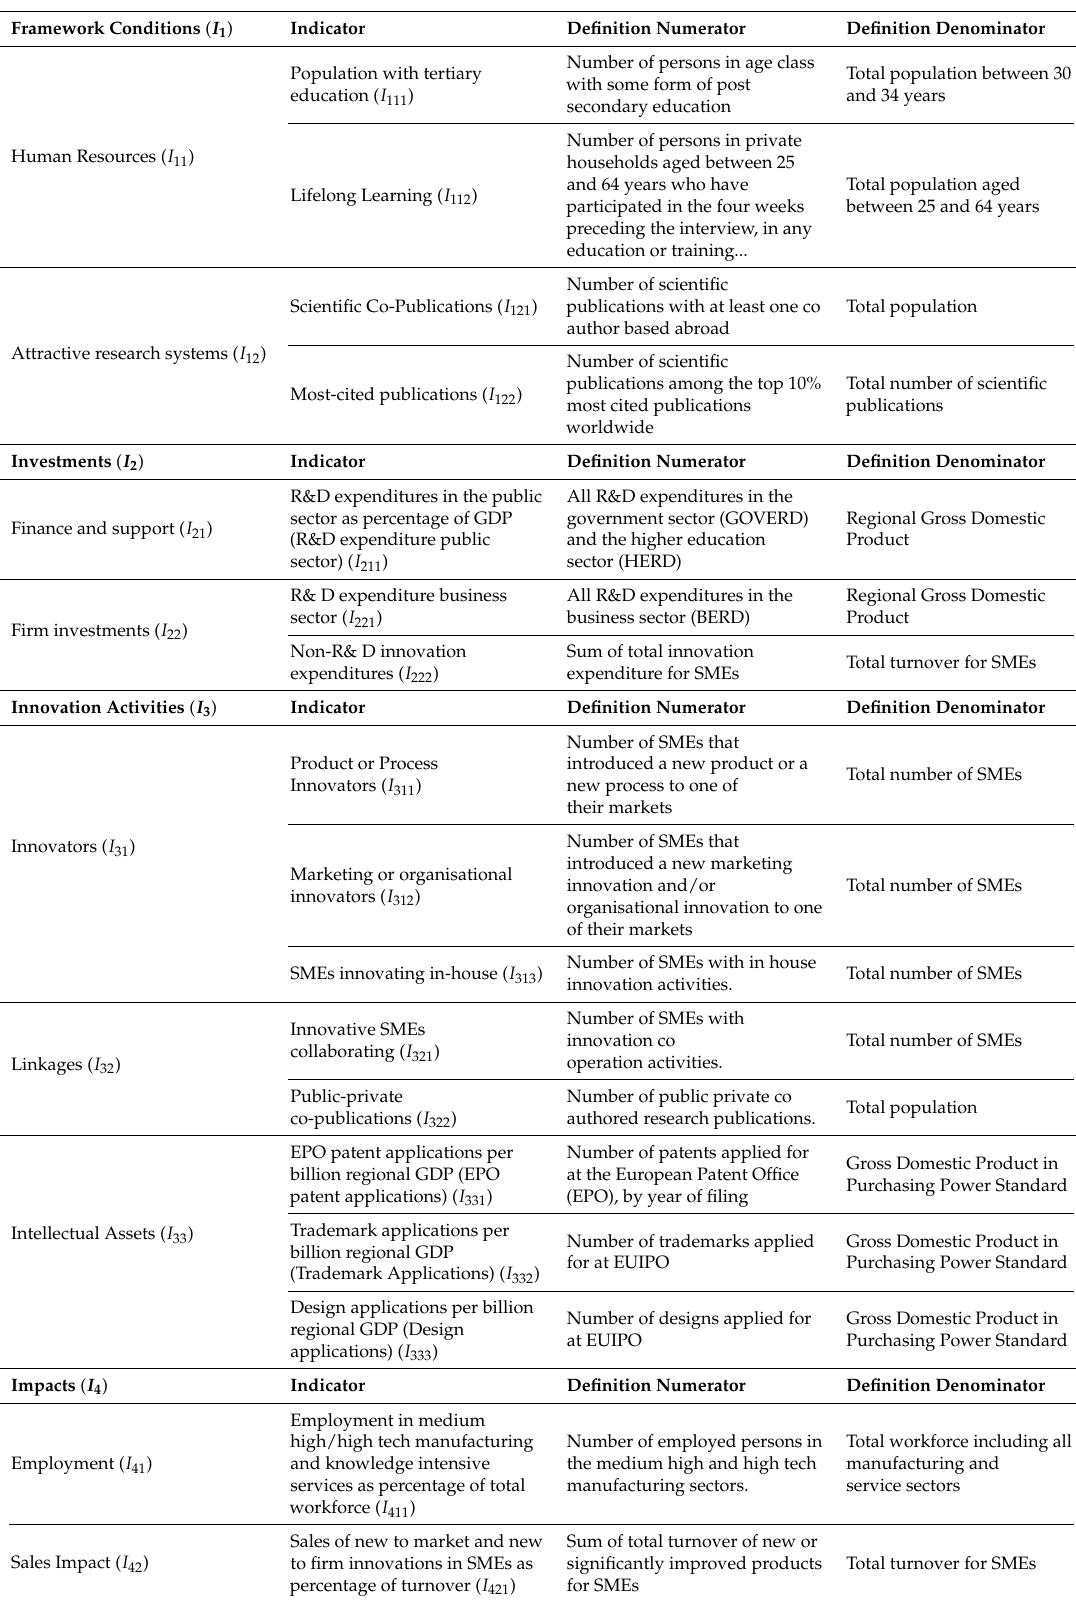
Table A1. RIS description for the elementary criteria. Source: